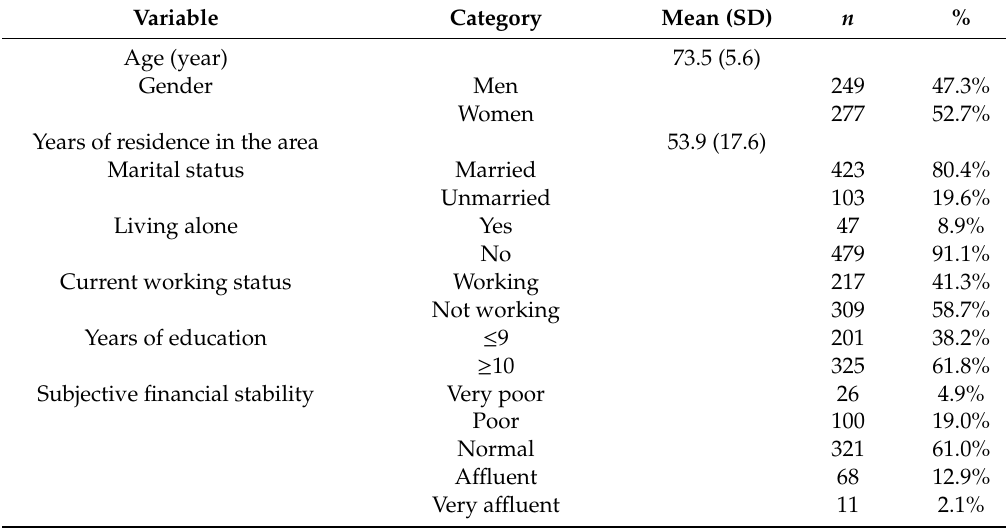
Table 1. Participants’ characteristics ( N =